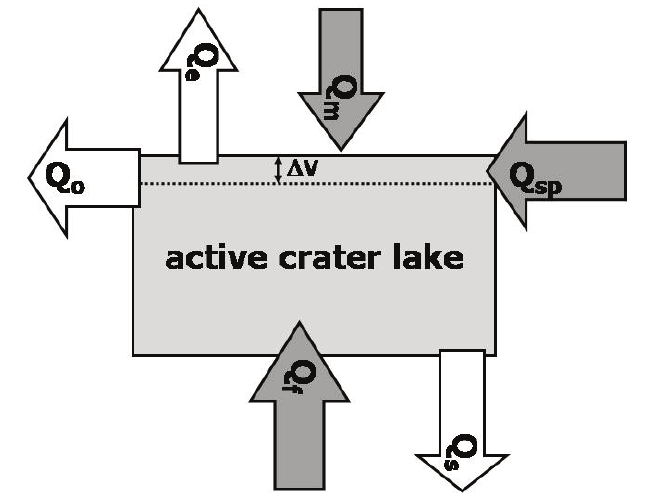
Figure 1. Box model for active crater lakes, observed for a period of time t to 0